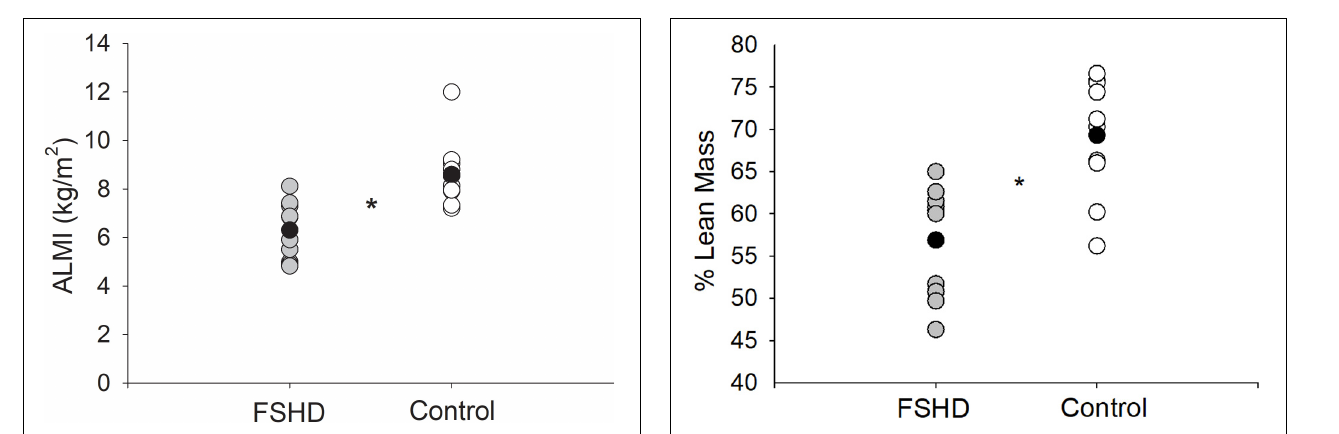
FIGURE 3 | % lean mass in FSHD and controls. Individuals with FSHD had a lower % lean mass, as compared to controls. Black circles indicate average data for each group. * p < 0.01.